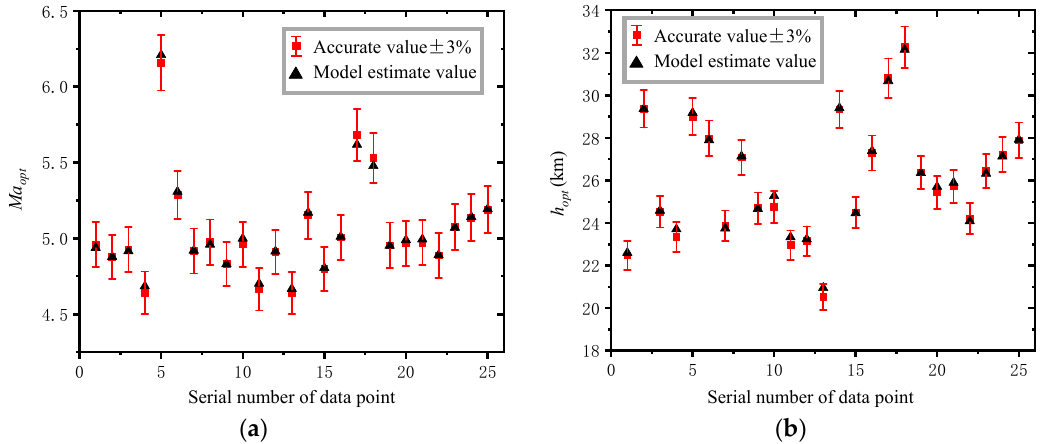
Figure 14. Comparison between estimated value and accurate value: ( a ) Estimated value and accurate value of Ma opt ; ( b ) Estimated value and accurate value of h opt .